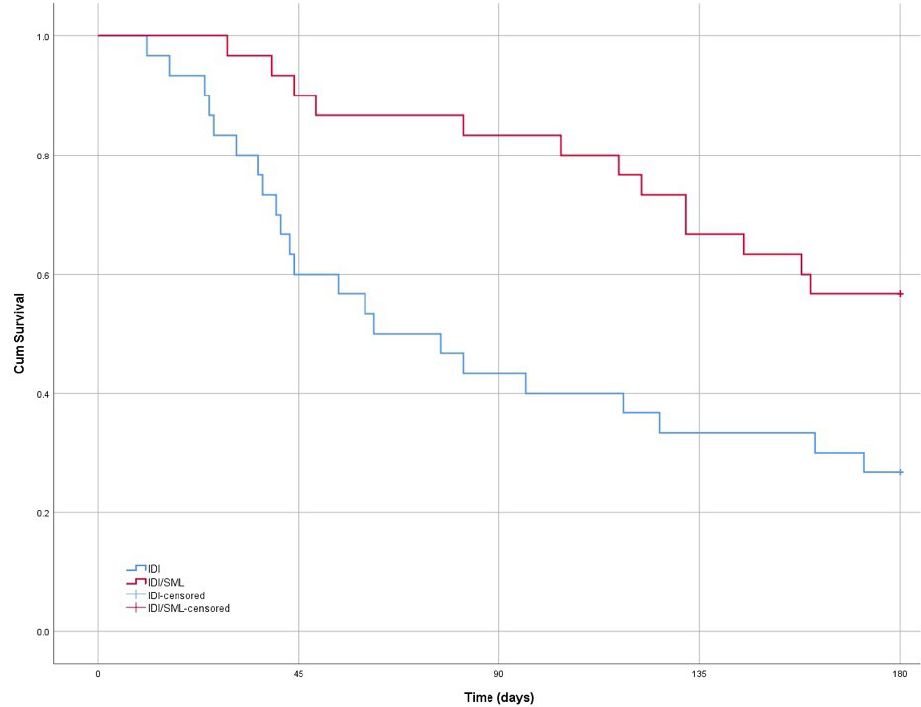
Figure 2. Kaplan–Meier Survival Curve comparison of the two groups showed a statistically signifi- cant difference in retreatment.